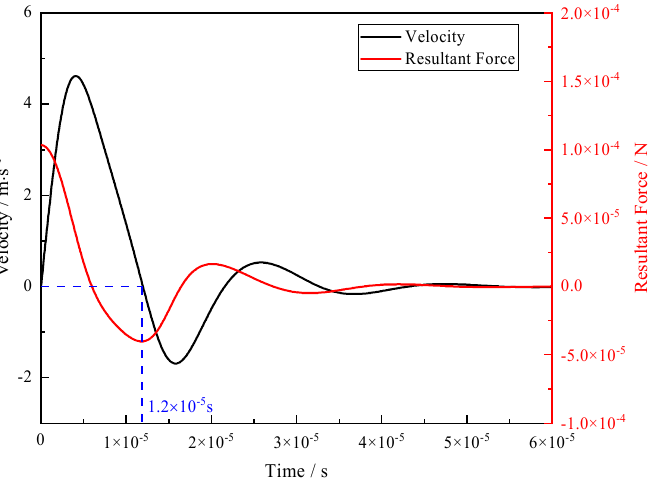
Figure 13. The velocity and resultant force changes of the low-melting-point CaO-MgO-Al 2 O 3 inclu- sions.